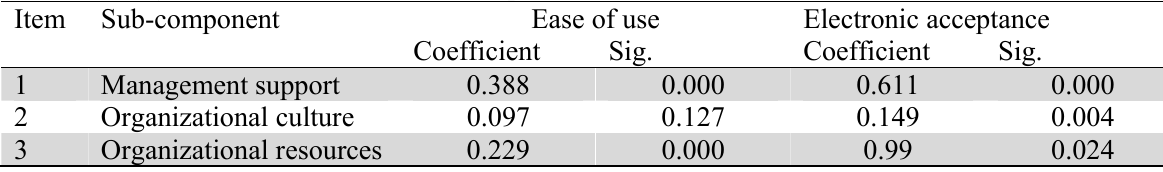
The summary of the effects of external